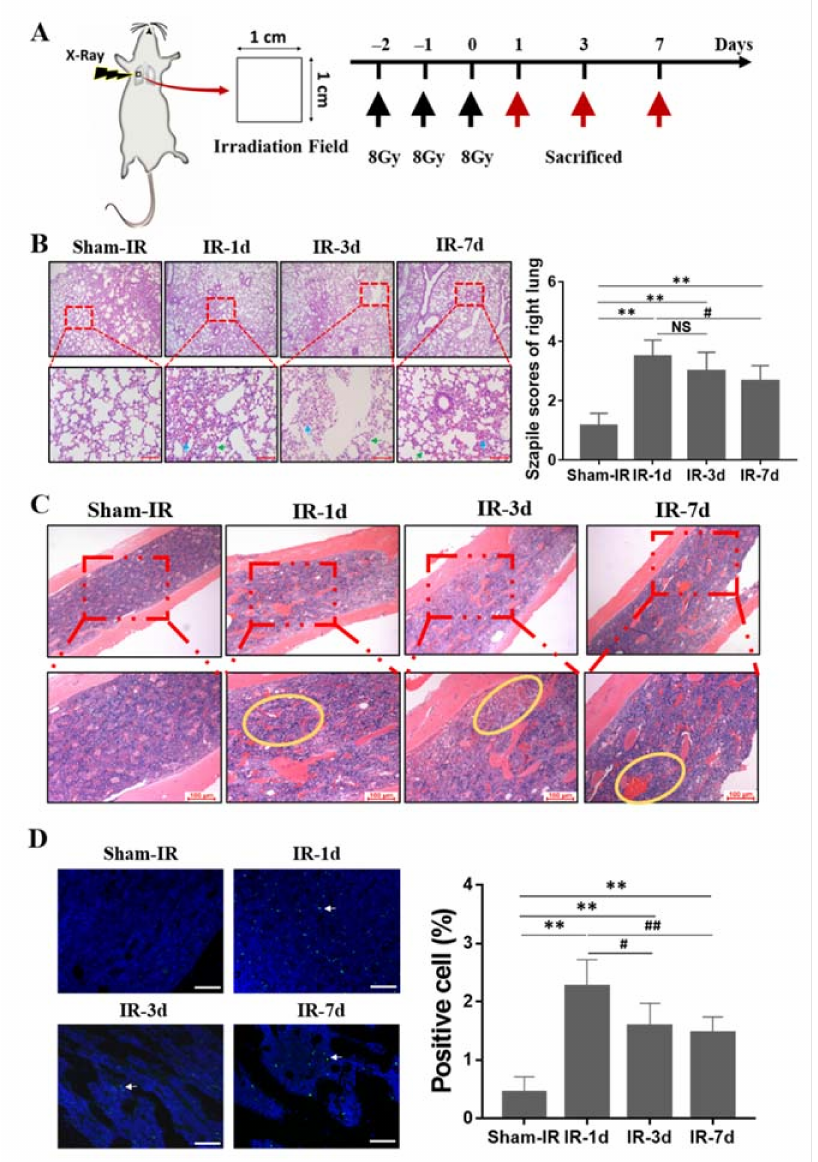
Figure 1. Thoracic irradiation (Th-IR) induces injuries in lung and bone marrow of mice. ( A ) The scheme of mouse irradiation and further analysis. 1 × 1 cm 2 on the right chest of the mouse was irradiated with 8 Gy X-rays each day for three days. The lung and bone marrow cells of the mice were taken for further measurements at one, three, and seven days after irradiation. ( B ) HE staining and Szapiel scores for the pulmonary alveolitis and inflammation of the irradiated lung. Green arrows indicate thickened alveolar wall. Blue arrow indicates hemorrhage exudate. Bar = 100 µ m. ( C ) HE staining of bone marrow tissue section. Yellow circles indicate tissue bleeding and damage. ( D ) TUNEL staining of bone marrow tissue section and the ratio of apoptotic cells in population. White arrows represent the TUNEL positively stained cells. Bar = 100 µ m. ** p < 0.01, compared with sham-IR group. # p < 0.05 and ## p < 0.01 compared with IR-1d group. NS: non-significant. n =